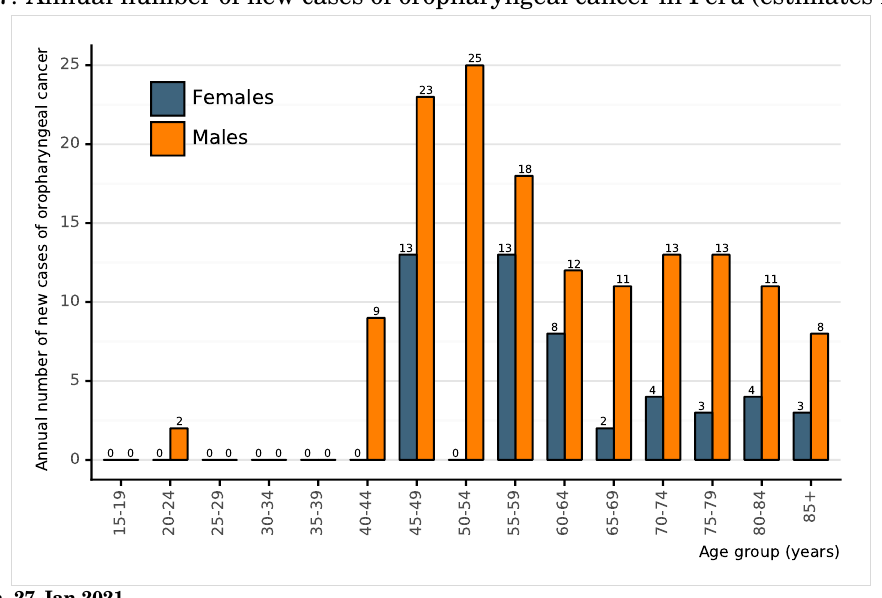
Figure 37: Annual number of new cases of oropharyngeal cancer in Peru (estimates for